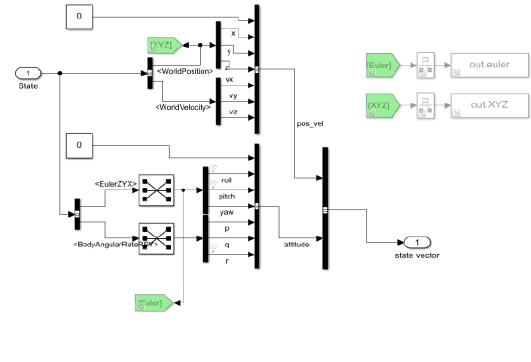
Figure 11. Basic architecture of Simulink and